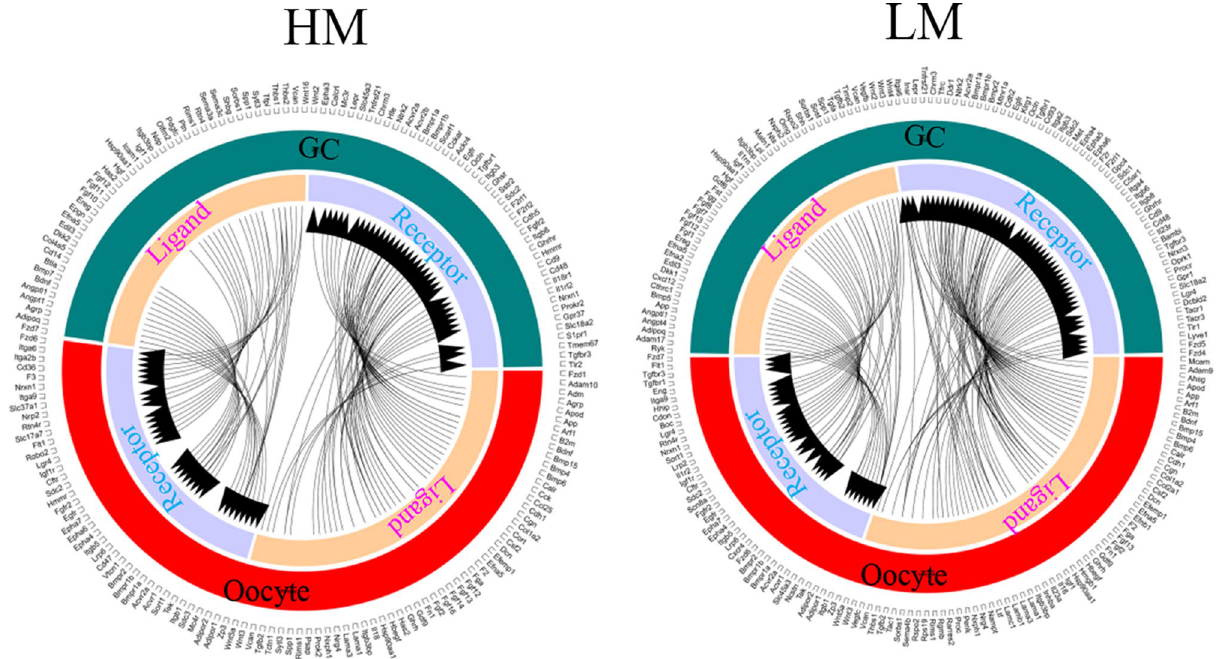
Figure 7. Ligand–receptor pairs, and ligand and receptor encoding genes expressed in high fertility and low fertility groups oocyte and GCs of goat medium follicles. Outside circle showed in GC or oocyte; while inside circle showed ligands or receptors. Free R package Circlize (version0.4.11; https:// cran.r- proje ct. org/ web/ packa ges/ circl ize/) software was used.